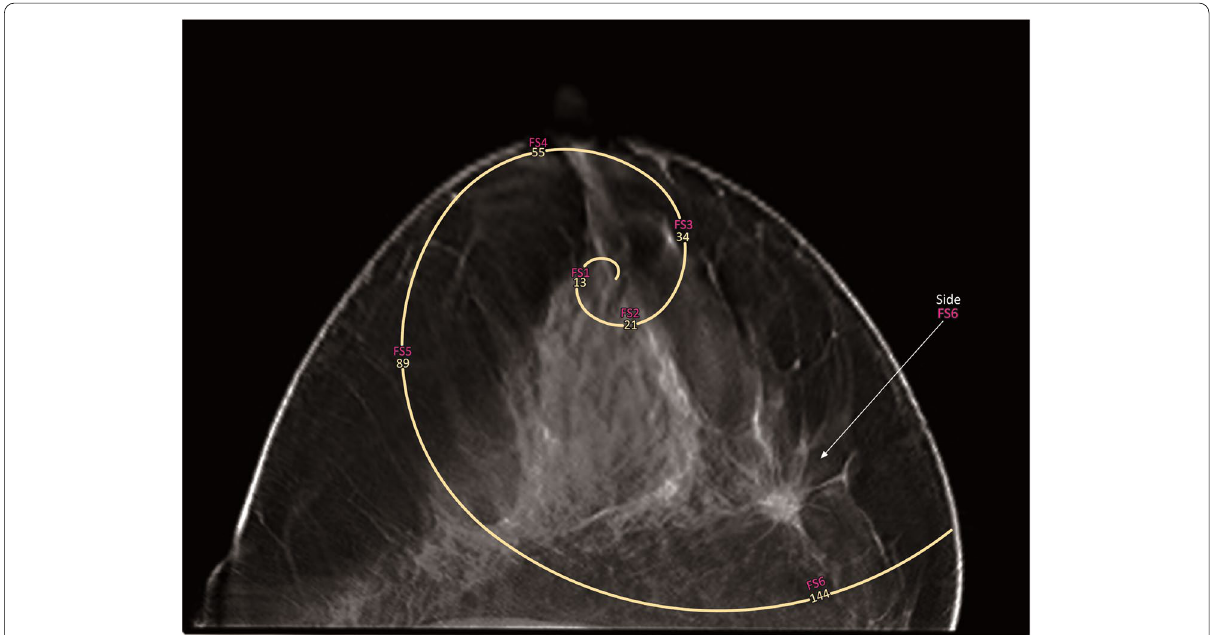
Fig. 3 Golden Ratio (Φ) Breast Cancer Detection And Fibonacci Sequence. Cranial-caudal view (CC) show Fibonacci Spiral approximates the Golden Ratio (Φ) using mammogram inscribed in squares of integer Fibonacci number side, shown for square size (13,21,34,55,89,144) making use the